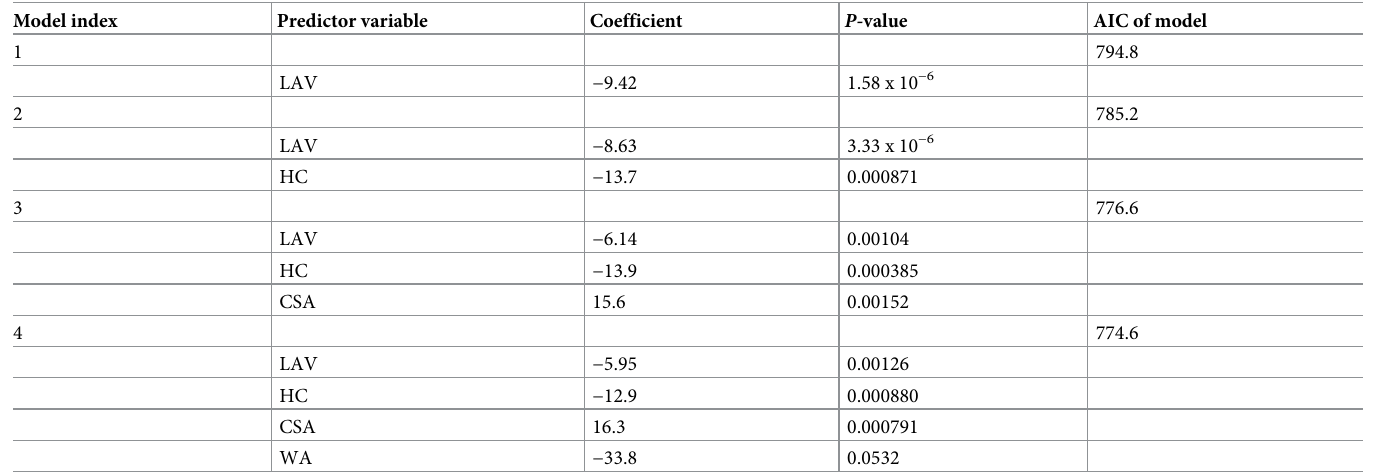
Table 3. Results of the linear model between FEV 1 and the COPD quantification. Model